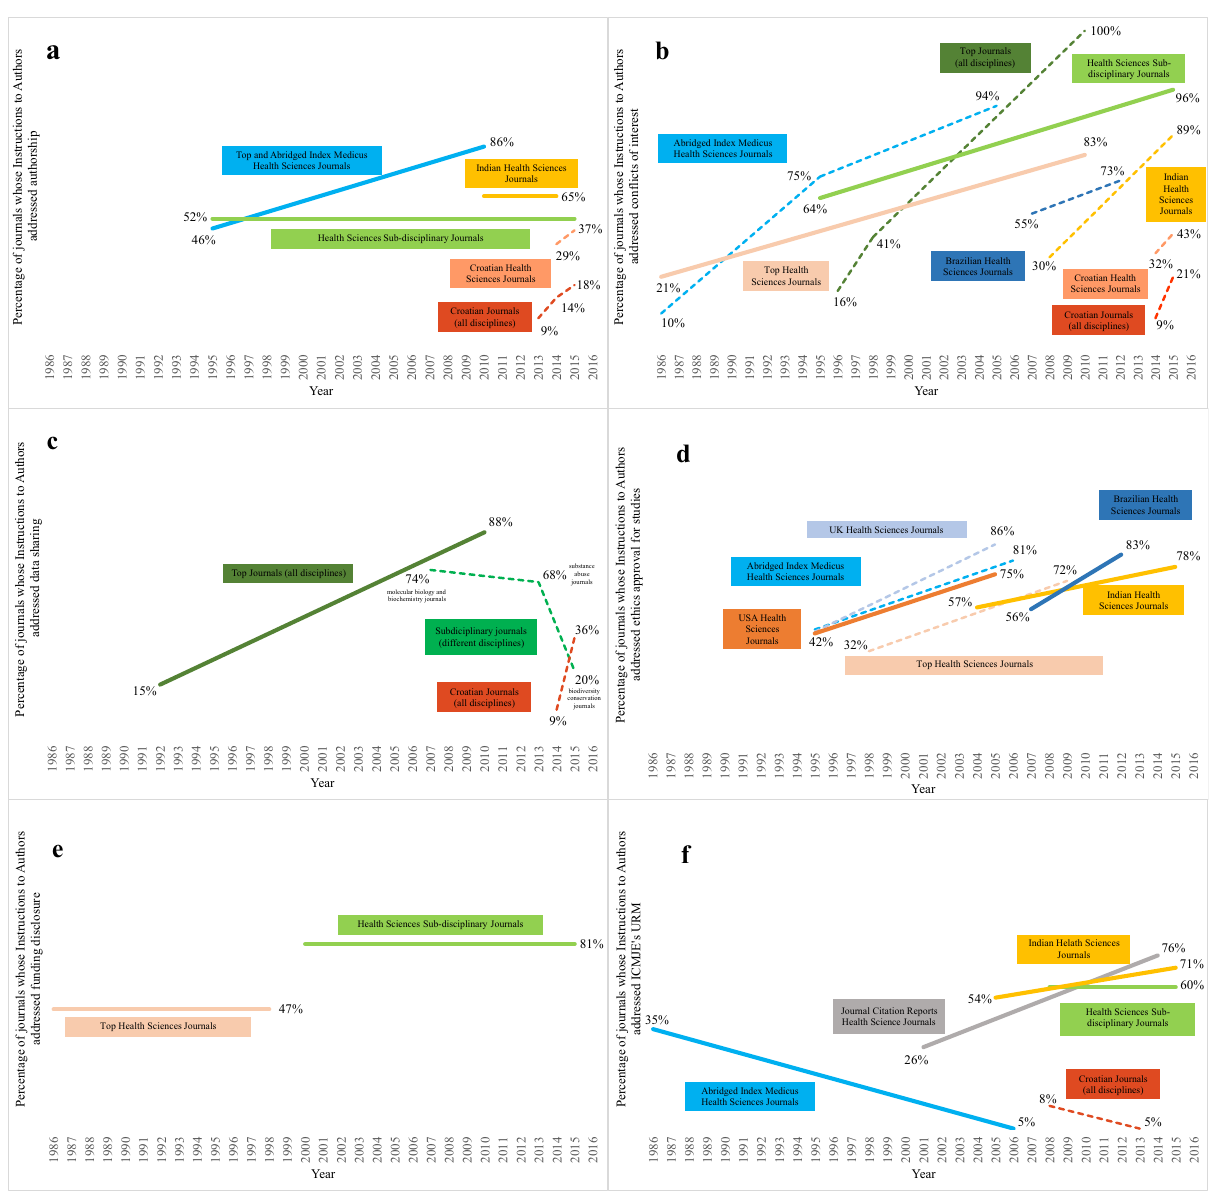
Fig. 3 Changes over time in addressing publication ethics in journals ’ Instructions to Authors. For ease of comparison all panels are on the same scale, with vertical axes based on a logit scale and percentages added as reference points. Panels represent changes over time for authorship ( a ), con fl icts of interest ( b ), data sharing ( c ), ethics approval ( d ), funding ( e ), and International Committee of Medical Journal Editors Uniform Requirements for Manuscripts ( f ). Full lines represent trends obtained through regression models, while dash lines represent percentages reported in up to three